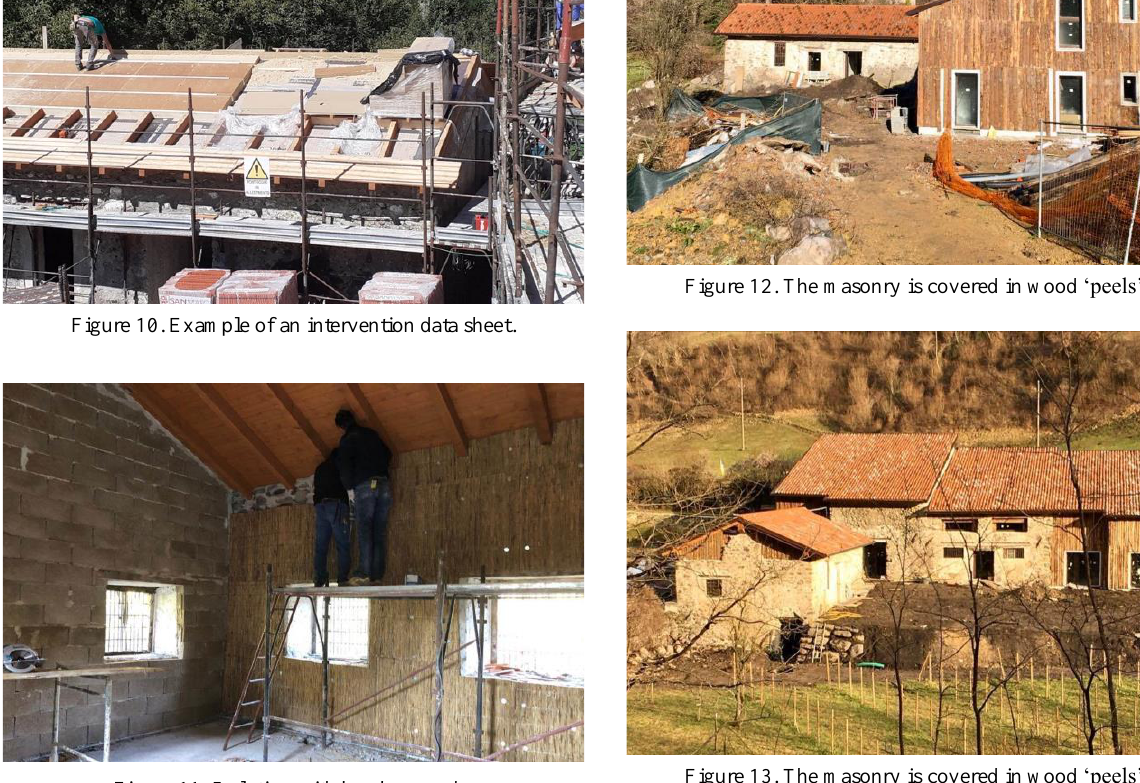
Figure 11. Isolation with bamboo reeds.